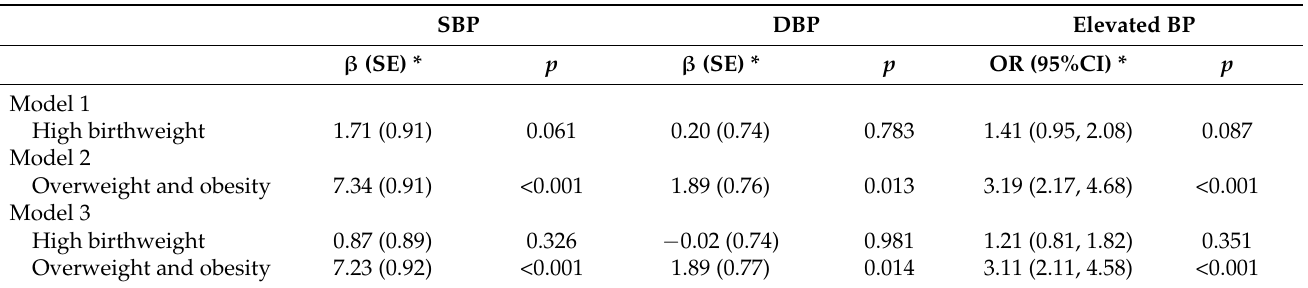
Table 3. Independent effects of birthweight and current overweight and obesity on elevated BP in adolescence.